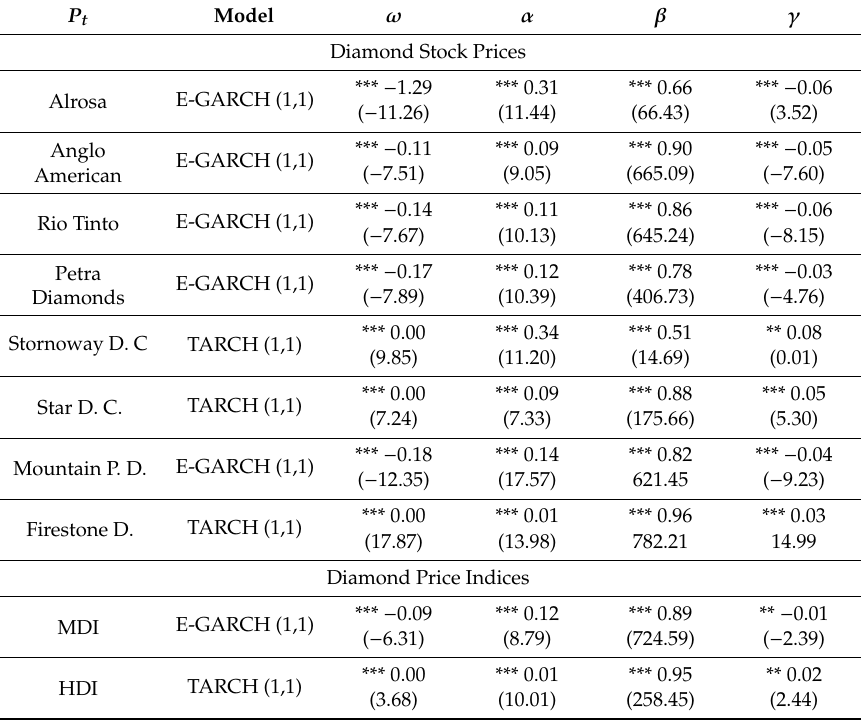
Table 7. GARCH parameters for diamond stock